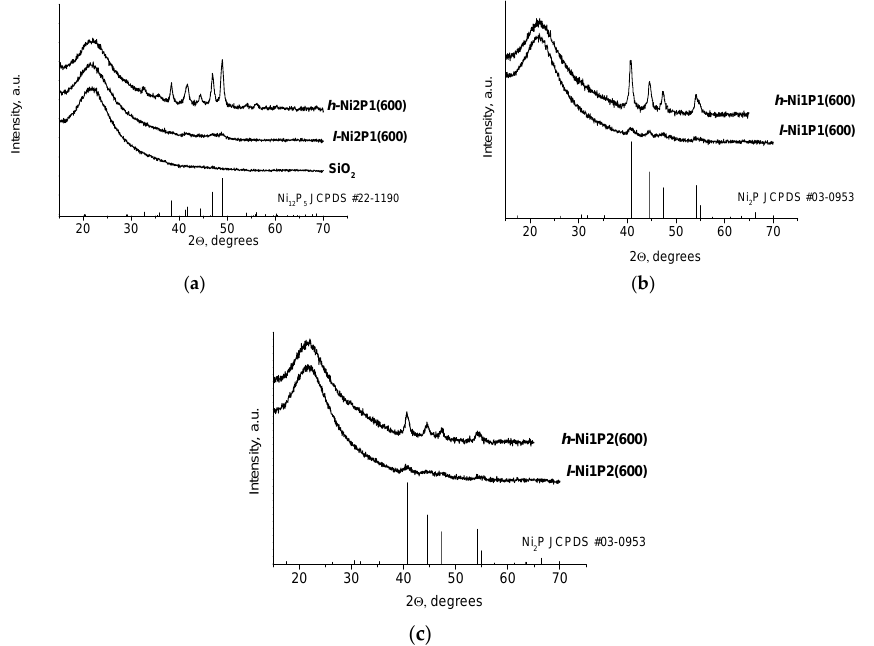
Figure 1. XRD patterns of silica ‐ supported Ni x P y catalysts and SiO 2 support: ( a ) h ‐ Ni2P1, l ‐ Ni2P1 and SiO 2 ; ( b ) h ‐ Ni1P1 and l ‐ Ni2P1; ( c ) h ‐ Ni1P2, l ‐ Ni1P2.